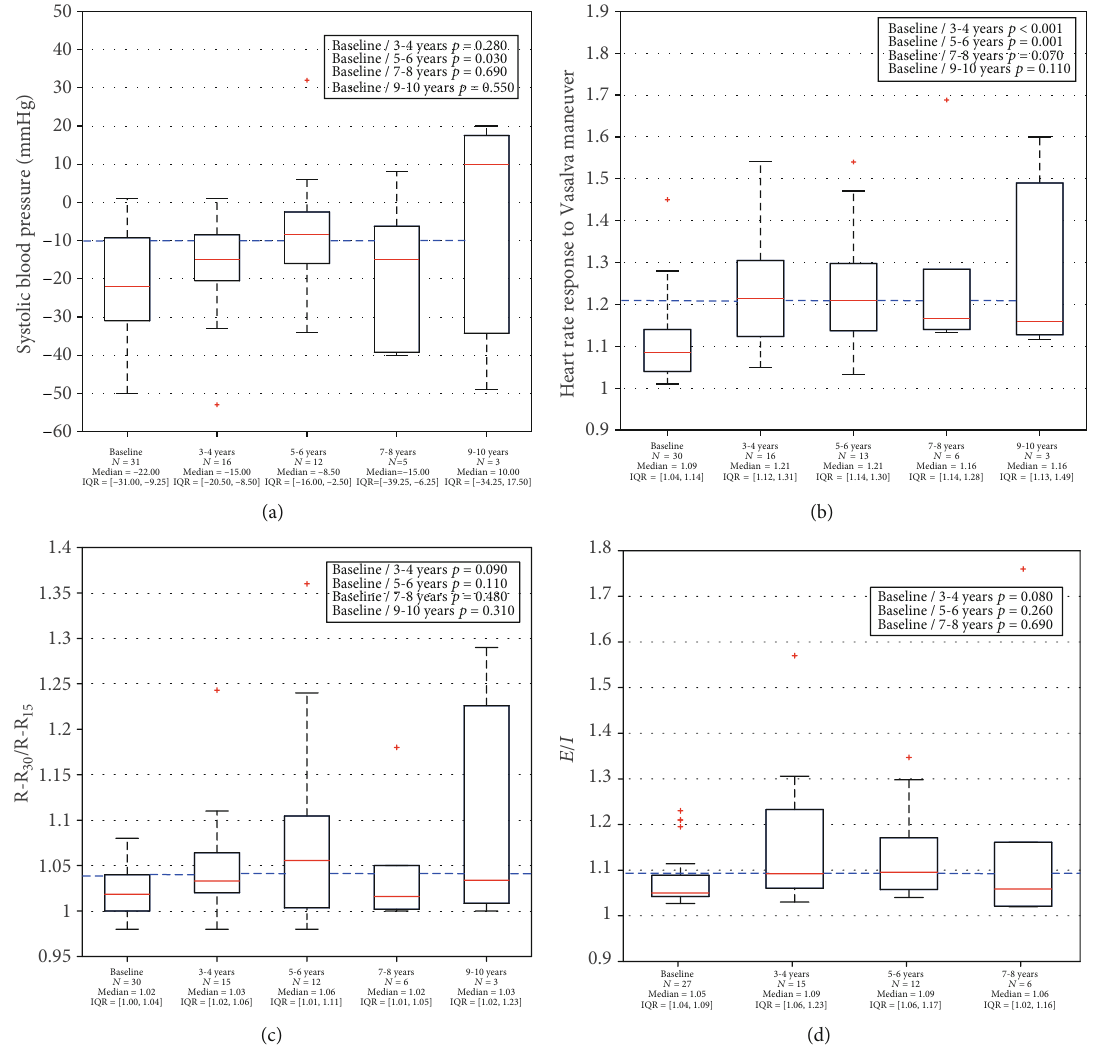
Figure 2: Results of cardiovascular function tests in SPK recipients, before and during the follow-up (textbox include paired t - tests ). (a) Systolic blood pressure response to orthostasis. (b) Heart rate response to the Valsalva maneuver. (c) Heart rate response to orthostasis (30 :15 ratio). (d) Heart rate variability with deep breathing ( E / I ). Data shown as median [interquartile range]. Interrupted line indicates lower limit of normal and borderline values from Sundkvist and Lilja (1985) [21] and Ewing et al. (1985) [23]. SPK: simultaneous pancreas and kidney